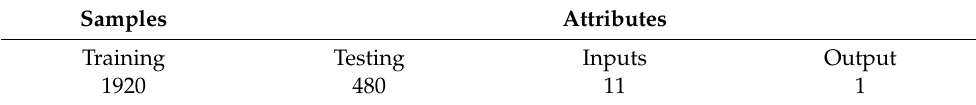
Table 10. Specification of vacuum two-line data